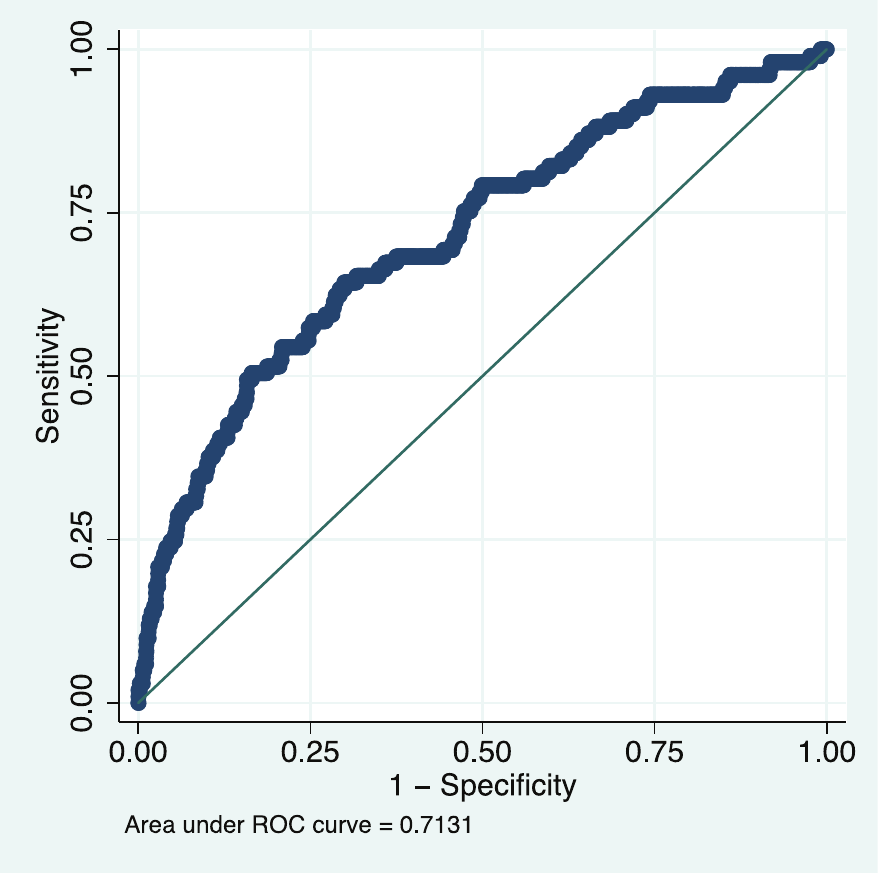
Figure 3. Receiver operating characteristic curve of the miniPIERS model applied to the fullPIERS (11) external validation cohort. AUC 0.713 (95% CI 0.658–0.768).